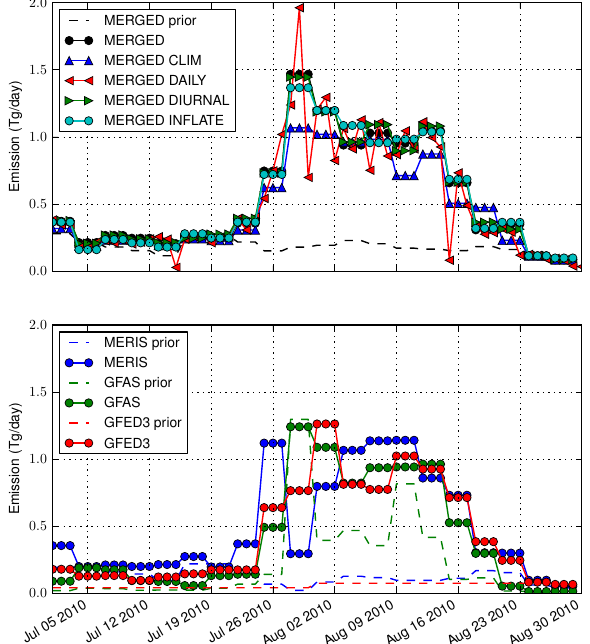
Fig. 4. Time variations of the prior and posterior emission esti- mates integrated over region R2 displayed in Fig. 3. The upper panel shows the MERGED prior and posterior emissions (see Table 1). The bottom panel shows prior and posterior emissions for scenarios MERIS, GFAS and GFED3 (see Table 1). Results for the three-daily periods are shown as three identical daily